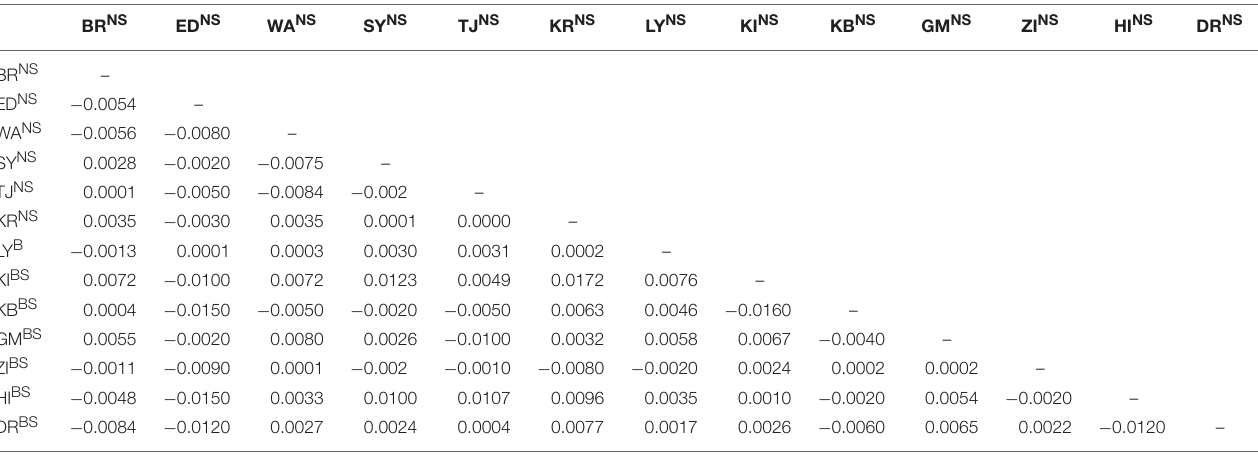
TABLE 3 | F ST values (pairwise differences) for the different sampling sites included in DS 1.